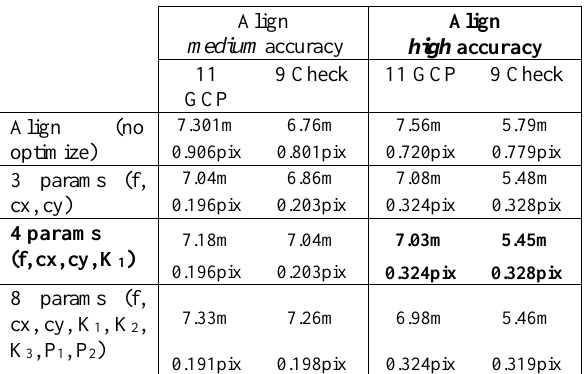
Table 2. Reference point residuals obtained when performing alignment of the 60 images with two accuracy modalities (Medium vs High), and computing self-calibrating bundle adjustment (Align result or Optimize for 3, 4 or 8 parameters). The retained solution is in bold. Camera models with more than 4 parameters do not improve point residuals significantly because model precision is mostly sensitive to camera network. Cameras are satisfactorily modelled with principal distance (f), and eccentricity (cx, cy) and a radial distortion parameter (K 1 ). Adding other parameters does not improve results.